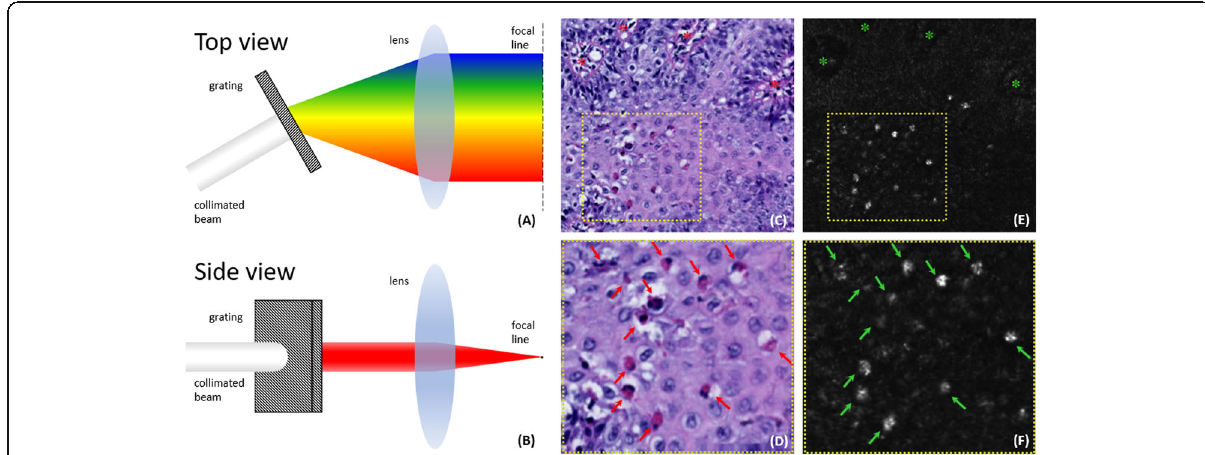
Fig. 8 Milestone 6: SECM for quantification of individual eosinophils. The working principle of SECM is illustrated in ( a ) and ( b ). A spectrally dispersed line is scanned over a region of interest enabling highly parallelized confocal microscopy imaging. Next to the corresponding H&E histology ( c ), ( d ), imaging results from the first SECM EoE biopsy study that illustrate the increased light scattering by eosinophils are depicted ( e ), ( f ) (figure and caption adapted and reprinted with permission from [117] © American Society for Gastrointestinal Endoscopy